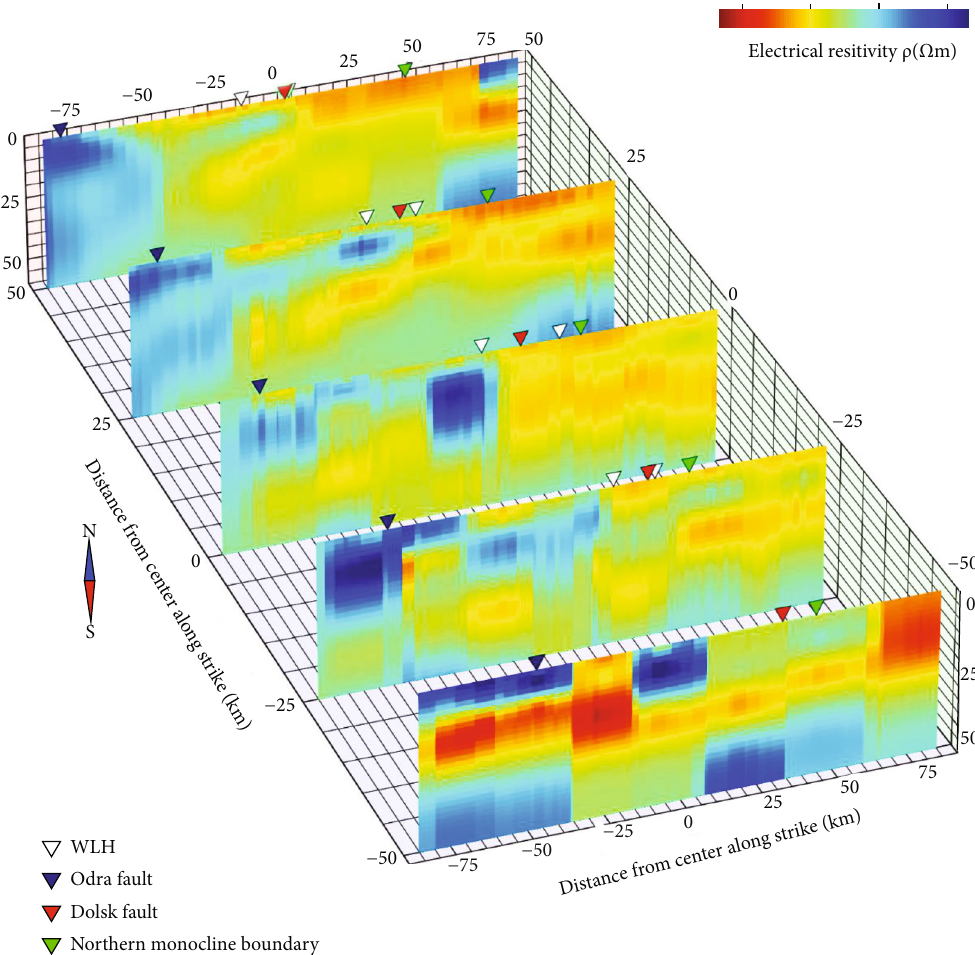
Figure 10: The presentation of 1D Occam inversion results in the depth range from 0 to 50km on individual pro fi